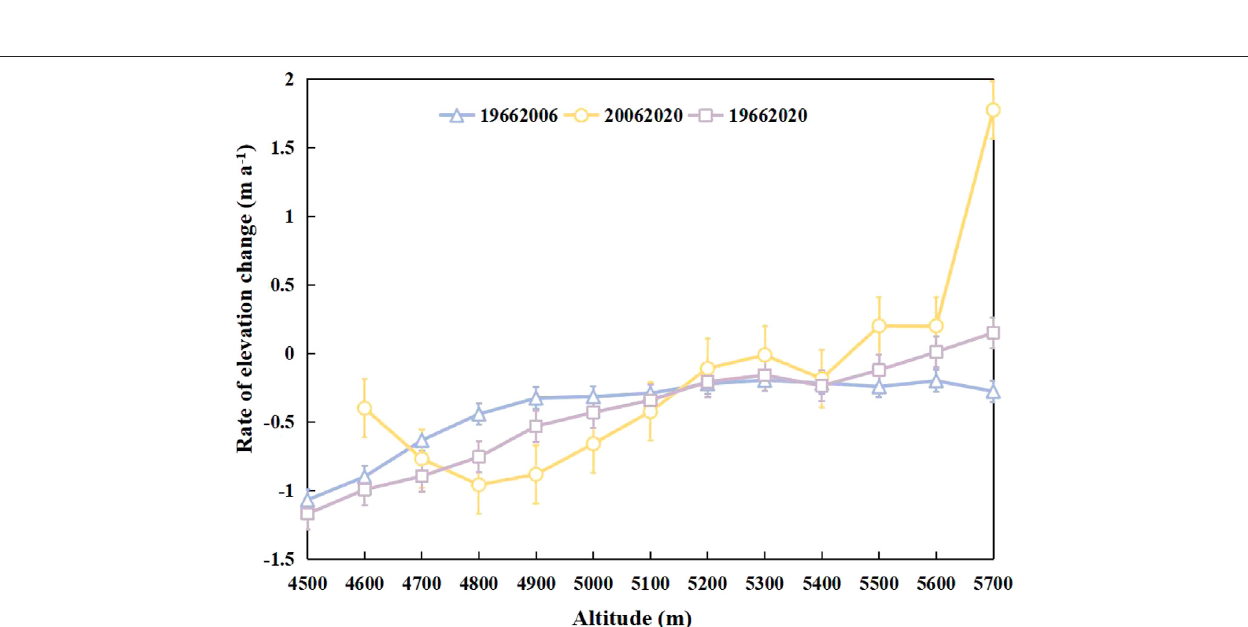
FIGURE 5 | Averaged glacier elevation change rate for each 100-m elevation